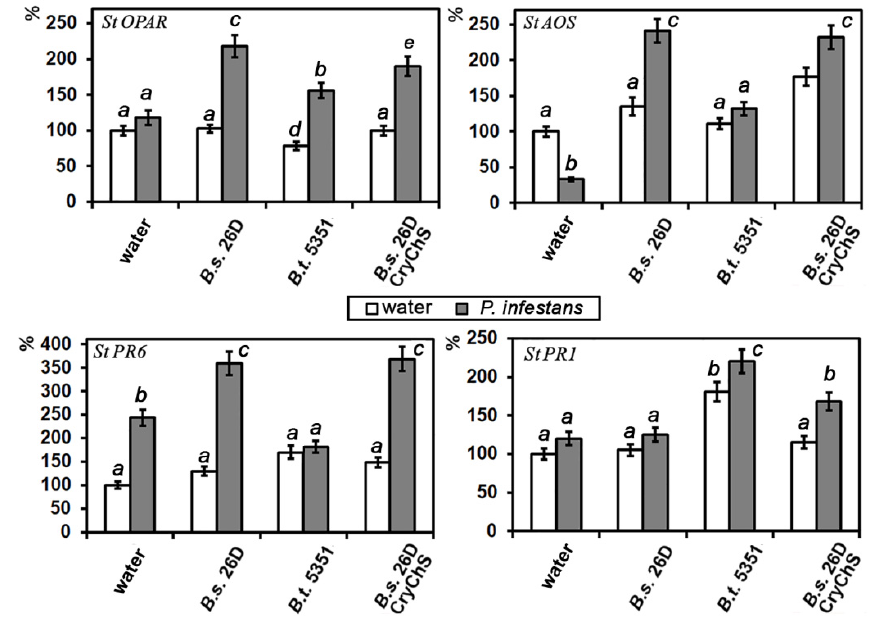
Figure 4. The effect of Bacillus strains on transcriptional activity of StPR6 , StPR1 , StAOS , and StOPAR genes in potato plants after 24 h post infection with P. infestans . Data presented as mean values ± standard error, values labeled by the same character are not significantly different from each other according to Student’s test p < 0.05.